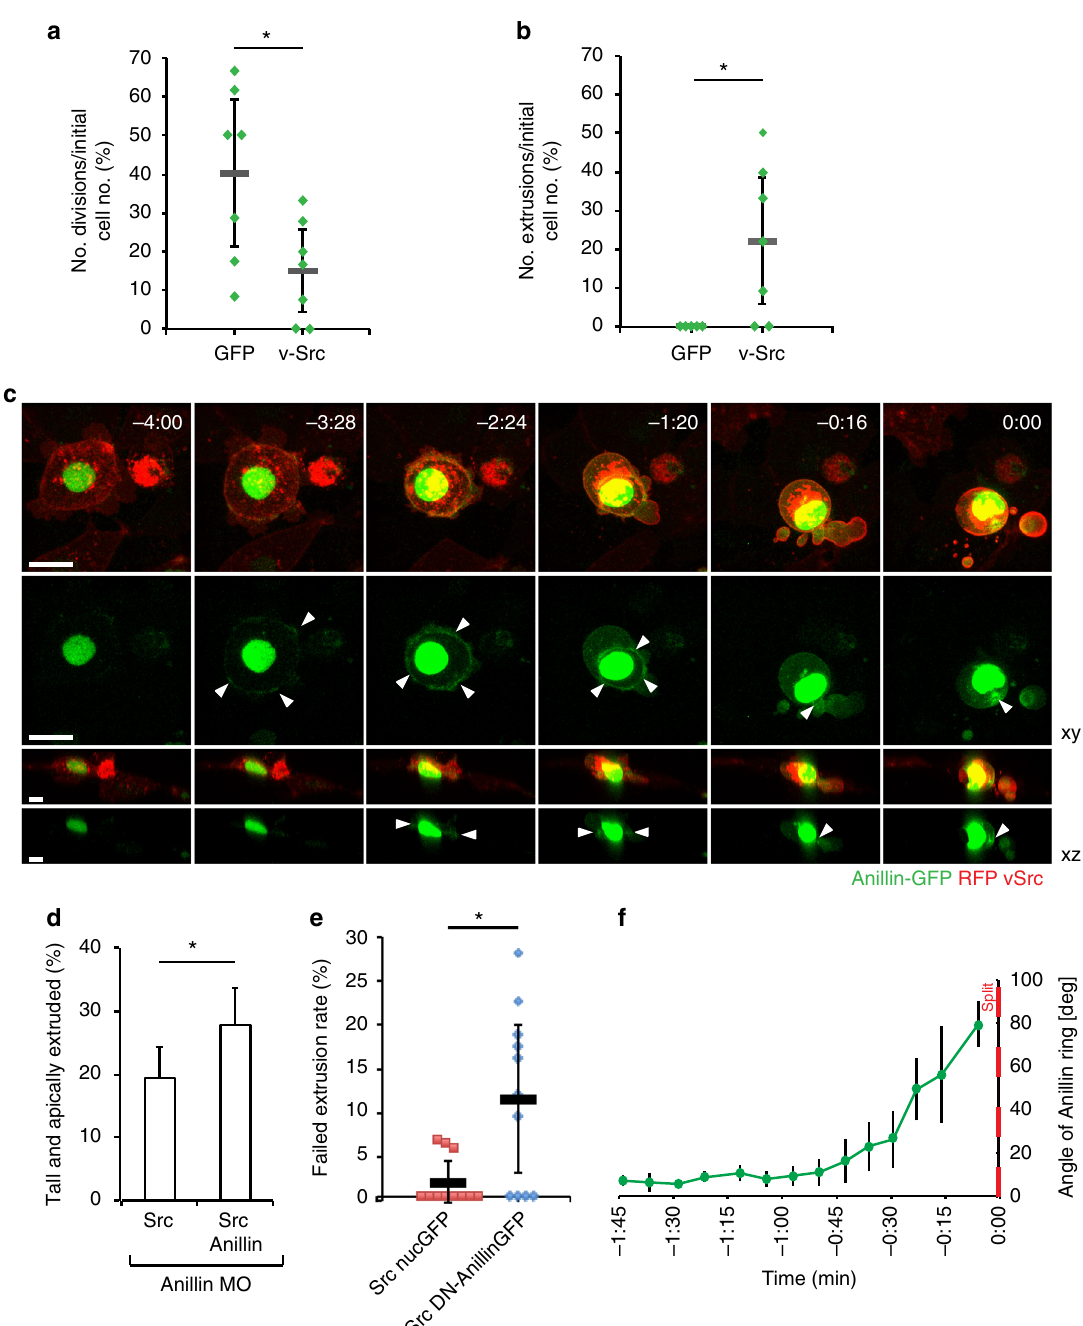
Fig. 2 Contractile Anillin ring is recruited to the lateral cortex prior to extrusion. a , b Quanti fi cation of EGFP and EGFP-vSrc cell division ( a ) and extrusion ( b ) rates based on time-lapse imaging. Division rates were calculated as the number of divisions over 4 h divided by the initial number of GFP-positive cells per embryo. Each mark represents a division rate in a single embryo. Grey lines represent mean values± standard deviation (s.d.). Seven embryos were imaged per condition in 14 independent experiments (total number of cells: n GFP = 121, n Src = 73). * P < 0.05 (Student ’ s t -test). c Time-lapse imaging of Anillin-GFP during vSrc cell extrusion. Embryos were injected with the dUAS:myr-Cherry-vSrc;Anillin-GFP construct. Movies were taken over 4 h. Frames were extracted from a representative movie at indicated times where t = 0 is the moment of extrusion. White arrowheads indicate the position of the Anillin ring. Scale bars, 25 µ m ( xy ) 10 µ m ( xz ). d The effect of exogenous Anillin on rescuing the Anillin morphant phenotype cell-autonomously in vSrc- driven extrusion. Embryos were injected with the following constructs: dUAS:EGFP-vSrc and dUAS:EGFP-vSrc,Anillin-GFP and the Anillin morpholino. Data are mean ± s.d. of three independent experiments (total number of embryos: n Src = 33; n Src,Anillin = 32). * P < 0.01 (Student ’ s t -test). e Quanti fi cation of the failed extrusion rate based on time-lapse imaging. Embryos were injected with the following constructs: dUAS:EGFP-vSrc;nucGFP and dUAS:EGFP-vSrc;DN- Anillin. Failed extrusion rates were calculated as the number of cells that rounded up and then returned to the monolayer without division or extrusion over 4 h by the initial number of GFP-positive cells per embryo. Each mark represents a division rate in a single embryo. Eleven embryos were imaged per condition in three independent experiments (total number of cells: n Src = 168, n Src,DNAnillin = 149). Grey lines represent mean values ± s.d. * P < 0.05 (Student ’ s t -test). f Quanti fi cation of the angle between the Anillin ring and the surface of the embryo over time. Data from four cells acquired in three independent experiments were then aligned to the time of extrusion, t = 0, averaged ± s.d. and